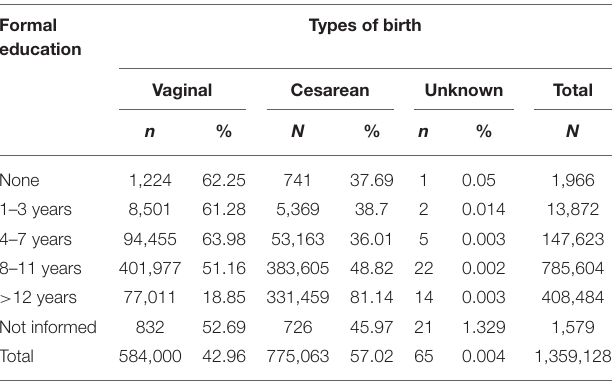
TABLE 4 | Distribution of the number and percentage of types of birth according to educational level of women attended in the city of São Paulo, between the years of 2010 and 2016 Source: SINASC/CEInfo/SMS-SP, 2018 ( São paulo, 2018). Formal